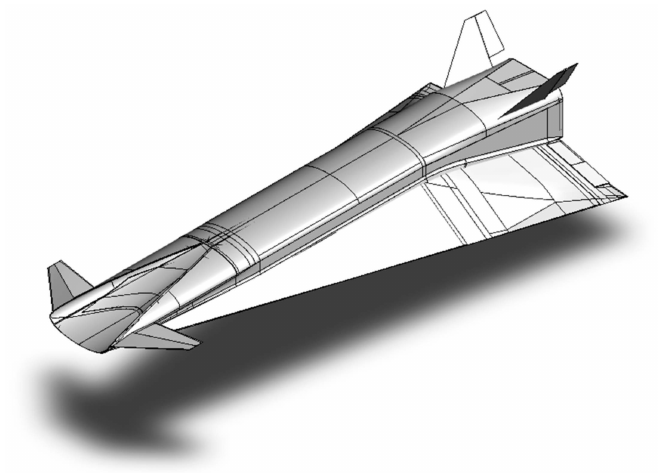
Figure 1. STRATOFLY MR3 layout.